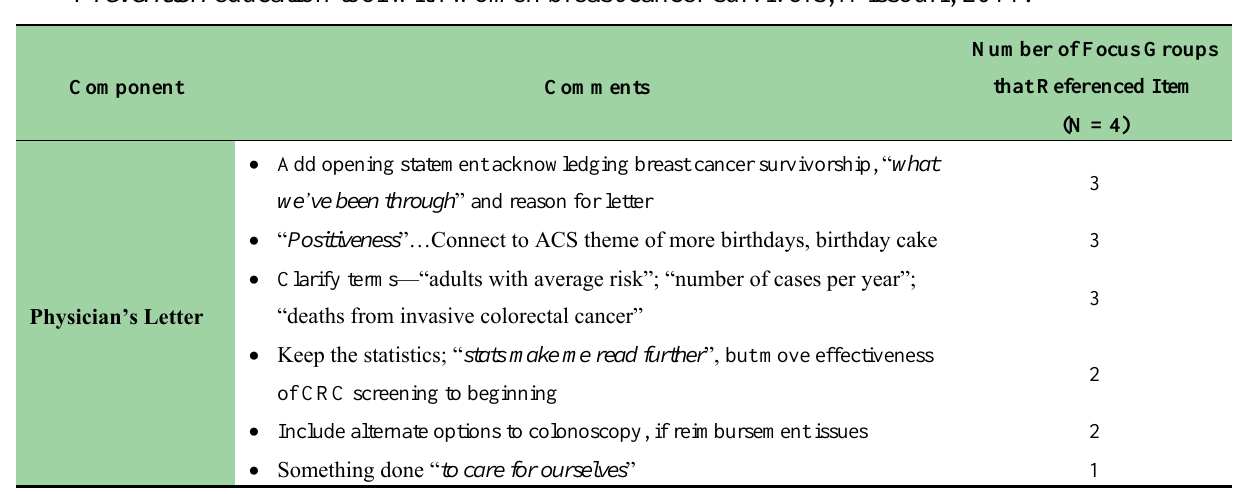
Table 2. Focus Groups review of the colorectal cancer prevention and screening Power of Prevention education tool with women breast cancer survivors, Missouri,